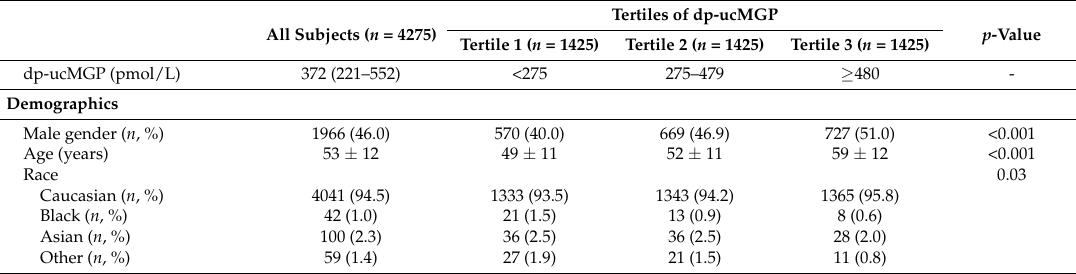
Table 1. Baseline characteristics of the study